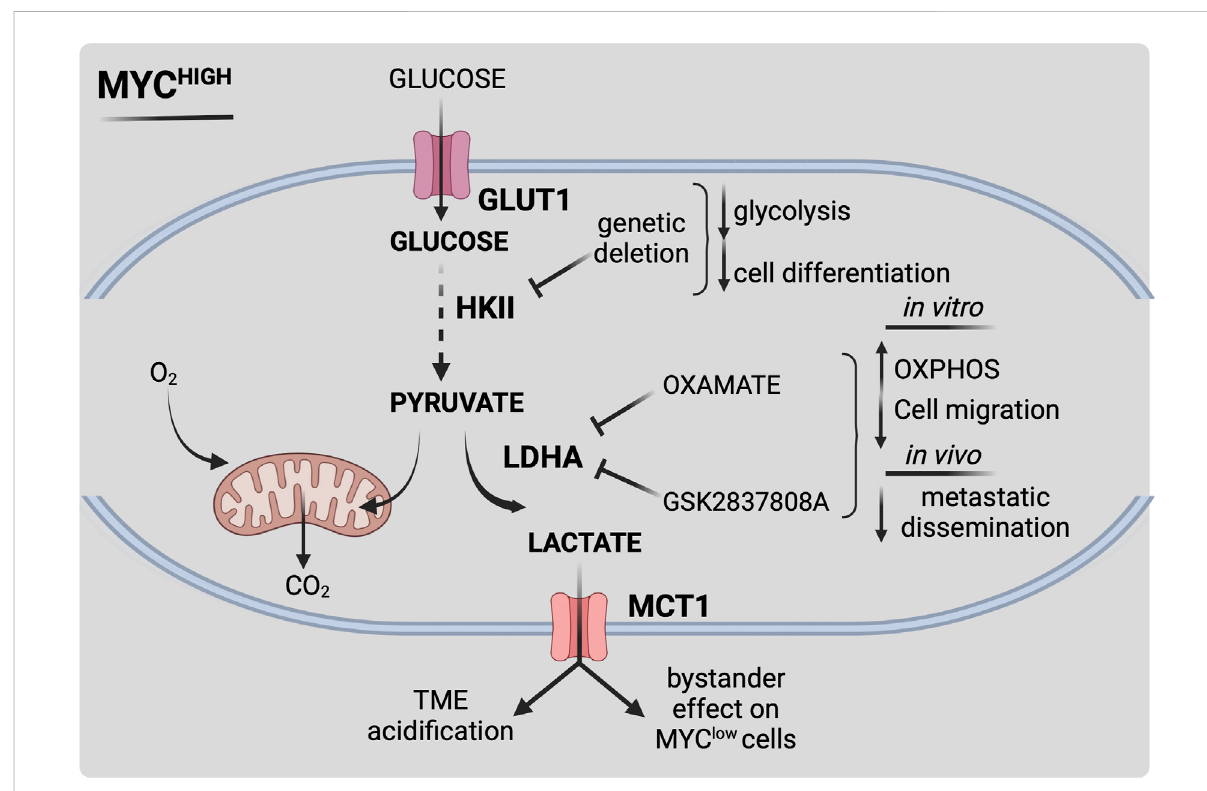
FIGURE 2 Schematic representation of MYC-dependent metabolic reprogramming in MB. MYC overexpression or ampli fi cation (MYC high ) drives metabolic reprogramming, leading to increased survival and therapy resistance. MYC-dependent alterations lead to enhanced aerobic glycolysis (i.e., Warburg effect) by a multiple-layered regulation. Activation of MYC stimulates glucose uptake by increasing transcription levels of glucose transporter GLUT1. MYC-dependent upregulation of hexokinase 2 (HKII) and pyruvate dehydrogenase kinase 1 (PDK1) fuels glucose fl ux within the cell. MYC highly contributes to extracellular acidi fi cation by acting on lactate synthesis and secretion through lactate dehydrogenase A (LDHA) and monocarboxylate transporter 1 (MCT1) expression, thus in fl uencing MB microenvironment. Pharmacological targeting of MYC-dependent key metabolic reactions could be effective towards high-risk MYC-driven MB. Figure is created in “ BioRender.com ”